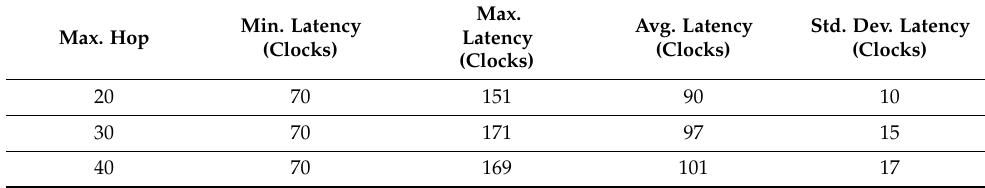
Table 5. Latencies of various hops for